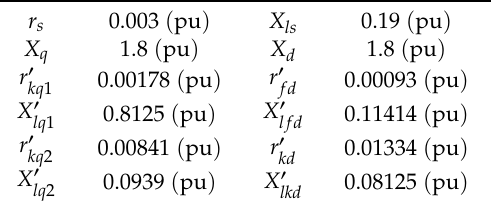
Table A1. Parameters of the synchronous generator.